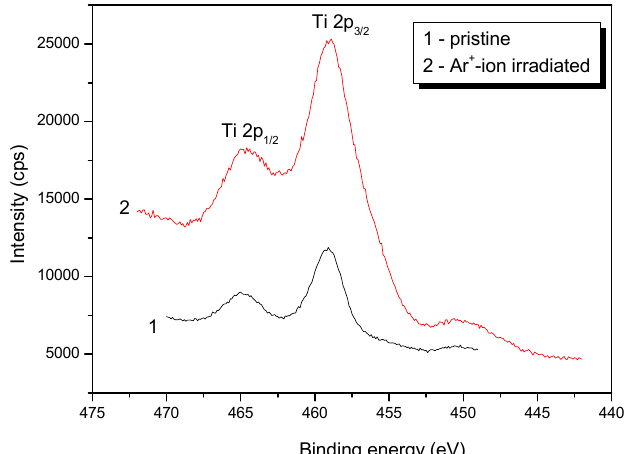
Figure 7. XPS spectra of the internal O 1 s-electrons of the investigated specimen before (1) and after (2) cleaning its surface with Ar + ions.